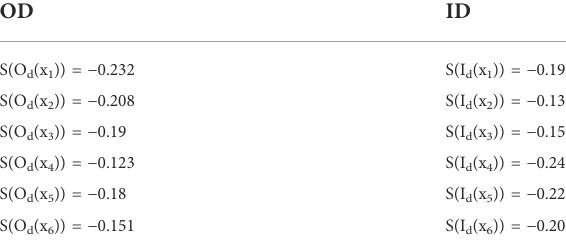
TABLE 7 Score value of out-degree and in-degree.